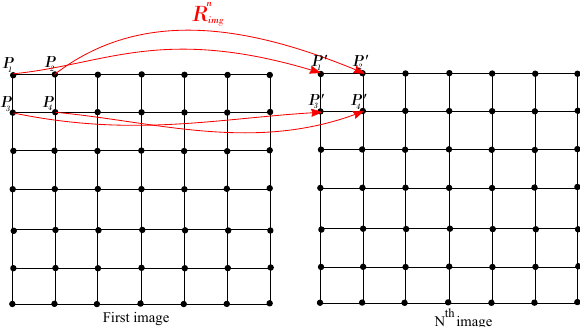
Figure 10. The accelerated approach of image transformation and resampling. T n is the geometrical transformation = R n img img between the first image and the N th image. p 1 , p 2 , p 3 , p 4 , are the corners of the first block of the first image. p 1 (cid:48) , p 2 (cid:48) , p 3 (cid:48) , p 4 (cid:48) are the projected points in the N th image. K × L is configured so that the shape of the block is always a square.